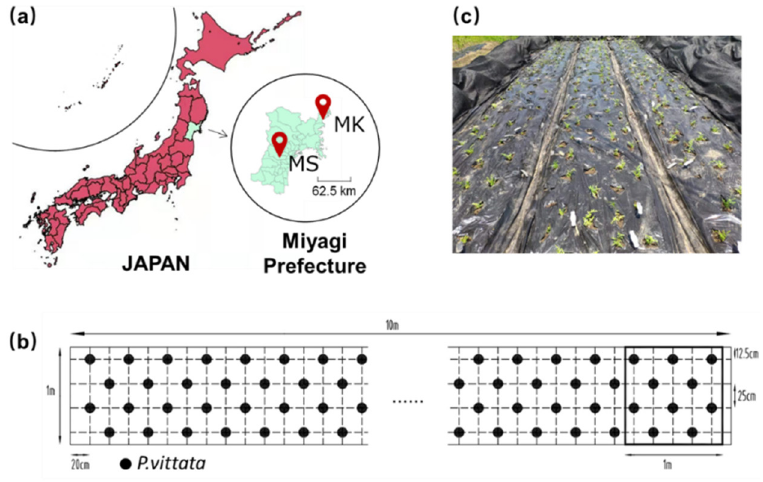
Figure 1. ( a ) Location of two sites in this study ( b ) planting design of P. vittata ( c ) photo after trans- planted.